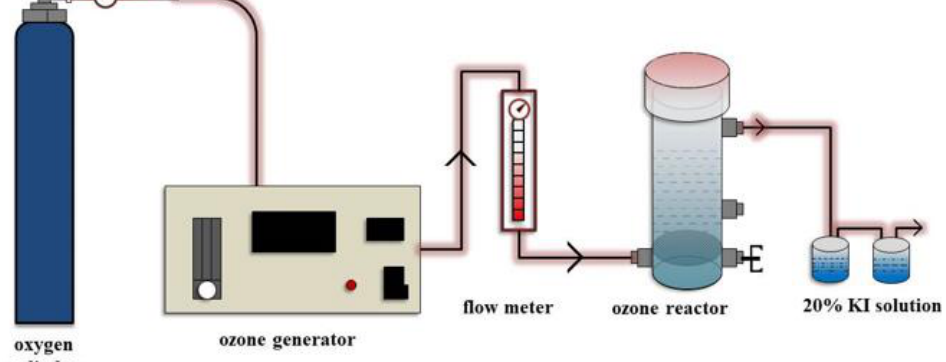
Figure 1. The schematic diagram of the catalytic ozone oxidation system.